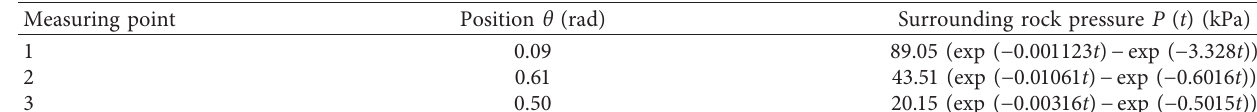
Table 3: Surrounding rock pressure.